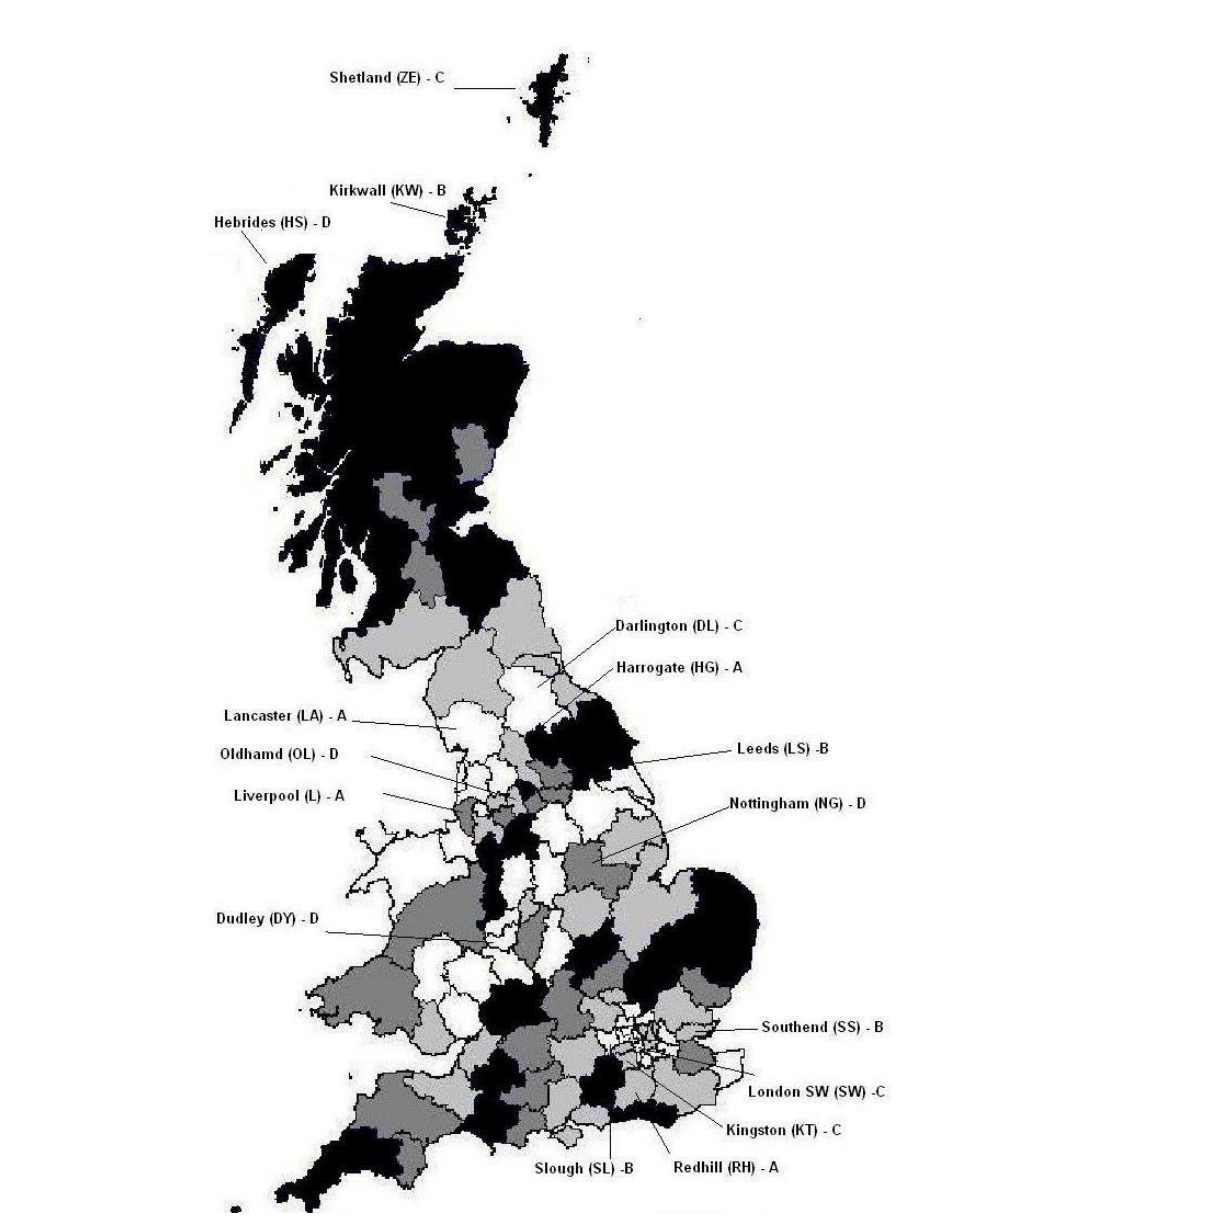
Figure 1. Registration rates by UK postcode area on Living Life To The Full between June 2008 and June 2009, showing four quartiles from darkest (top quartile) to white (lowest quartile) and 16 postcode areas (postcode letters; trial arm) sampled for study and randomized to four arms